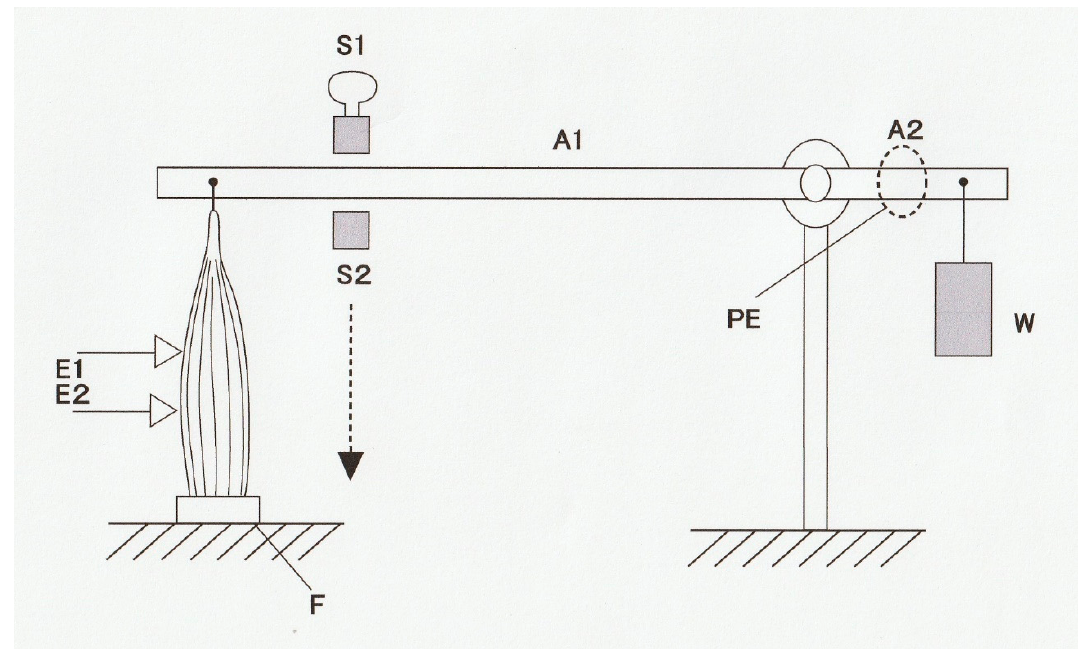
Figure 1. Experimental setup to record the force–velocity relation of skeletal muscle. A frog sartorius muscle (M) is held vertically between the long arm (A1) of the lever and a force transducer (F), while a weight W is put to the short arm (A2) of the lever to apply constant afterload ( P) to the muscle. Muscle length is initially adjusted by stops (S1 and S2) at a slack length (Lo) where resting force is just barely perceptible. Then, the muscle is stimulated by a single electrical current pulse through a pair of electrodes (E1 and E2) to produce a twitch (at 0 ◦ C). Force and length changes in the muscle during a twitch are recorded by a force transducer (F) and a photoelectric device (PE), respectively.